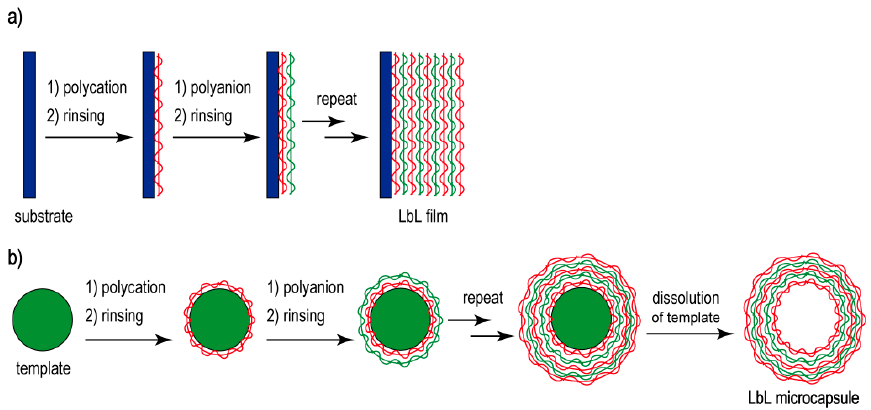
Figure 1. Preparation of layer-by-layer (LbL) films ( a ) and microcapsules ( b ). Hydrogen bonding is also available as a driving force for the preparation of LbL